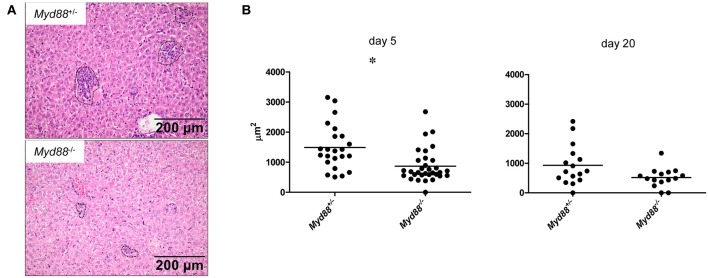
MyD88-dependent granulomatous inflammation in livers of C. burnetii-infected mice. Myd88+/− and Myd88−/− mice were infected i.p. with 5 × 107 CFU NMII. H&E stained liver sections were analyzed for leukocyte infiltrates by histopathology (magnification 100x). (A) Granuloma-like structures were marked (indicated by dashed lines in photomicrographs, shown are examples from day 5 post infection) and the total area of all marked granulomas per field of view was measured (ZEN software, Zeiss). Eight fields of view were analyzed per individual mouse (B). Results were analyzed using an unpaired two-tailed Mann-Whitney U test. (d5: n = 3 for Myd88+/−, n = 4 for Myd88−/−; d20: n = 2 for both genotypes).